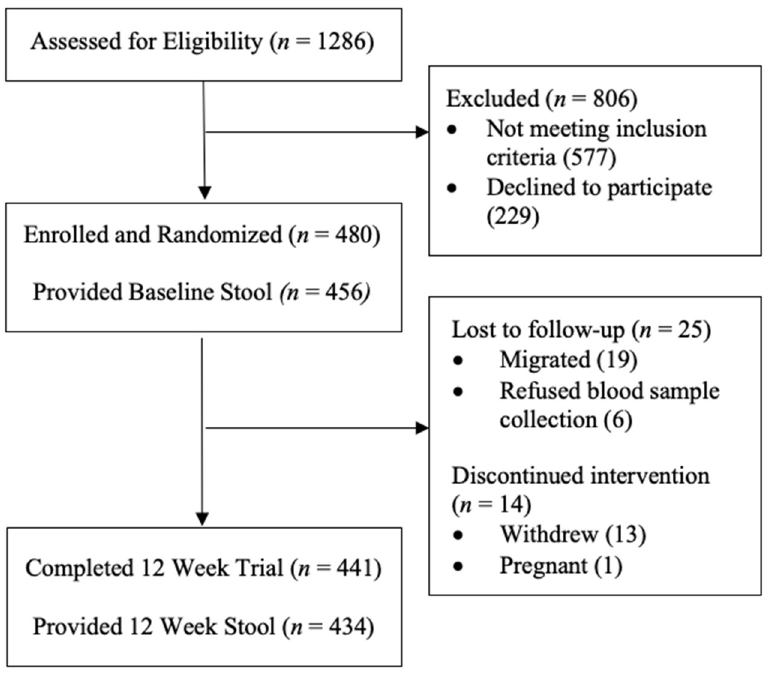
Figure 3. Participant flow chart. Table 1. Baseline participant characteristics of enrolled Cambodian women by provision of baseline stool specimen.